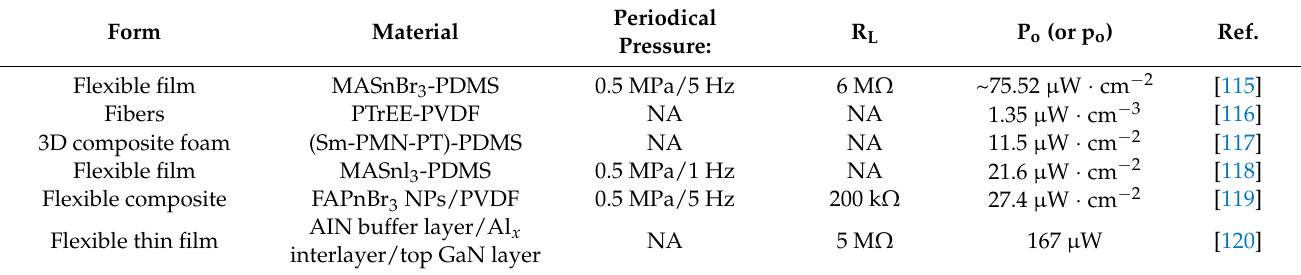
Table 8. Comparison of different